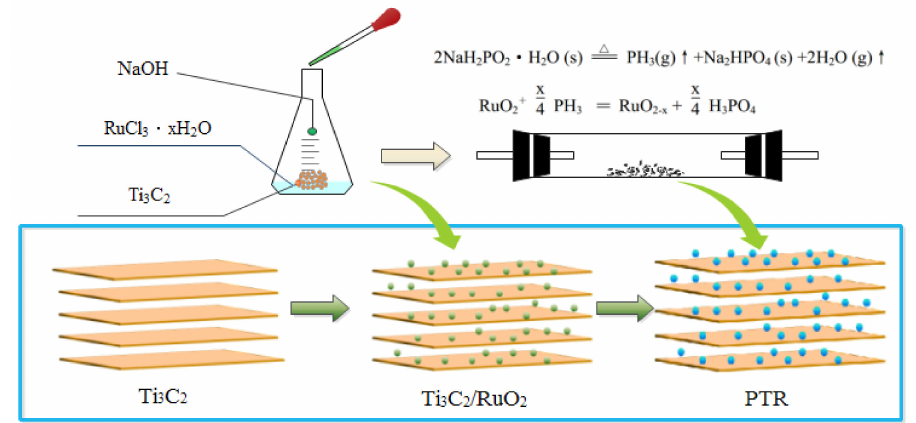
Figure 1. Schematic illustration of the procedure for preparing the phosphate ion-modified RuO 2 / Ti 3 C 2 composite